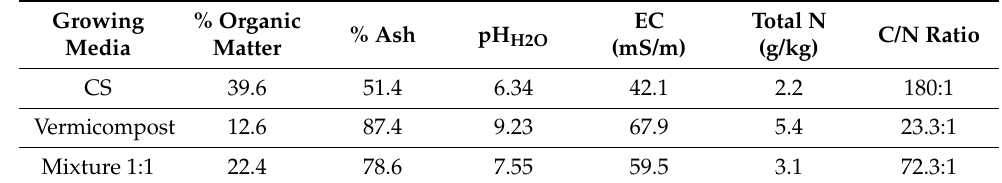
Table 1. Basic properties of the growing media commercial substrate (CS), vermicompost and mixture 1:1.